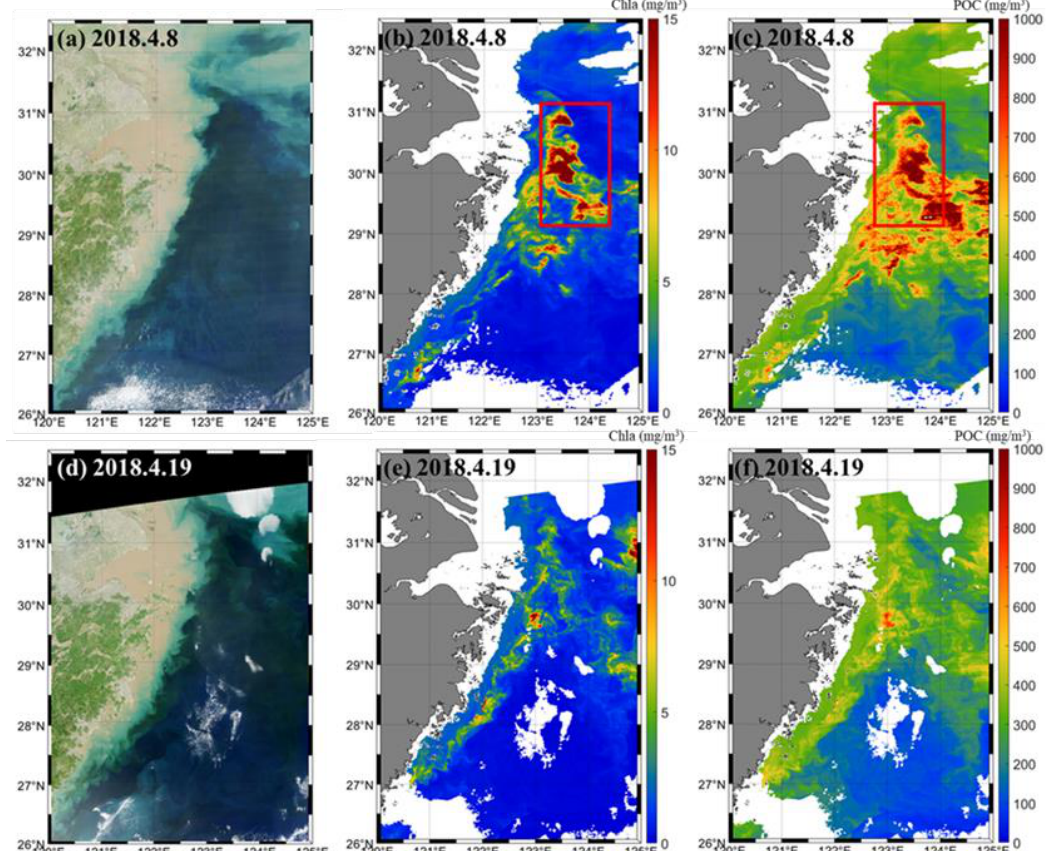
Figure 7. ( a ) is the true-color MODIS remote sensing image when the phytoplankton bloom event occurred in the East China Sea; ( b , c ) are the chlorophyll-a and POC distribution maps at the time of the phytoplankton bloom, respectively; ( d ) is the true-color MODIS remote sensing image ten days after the phytoplankton bloom event occurred in the East China Sea; ( e , f ) are the chlorophyll-a and POC distribution maps approximately ten days after the phytoplankton bloom (the red boxed area is the identified phytoplankton bloom).